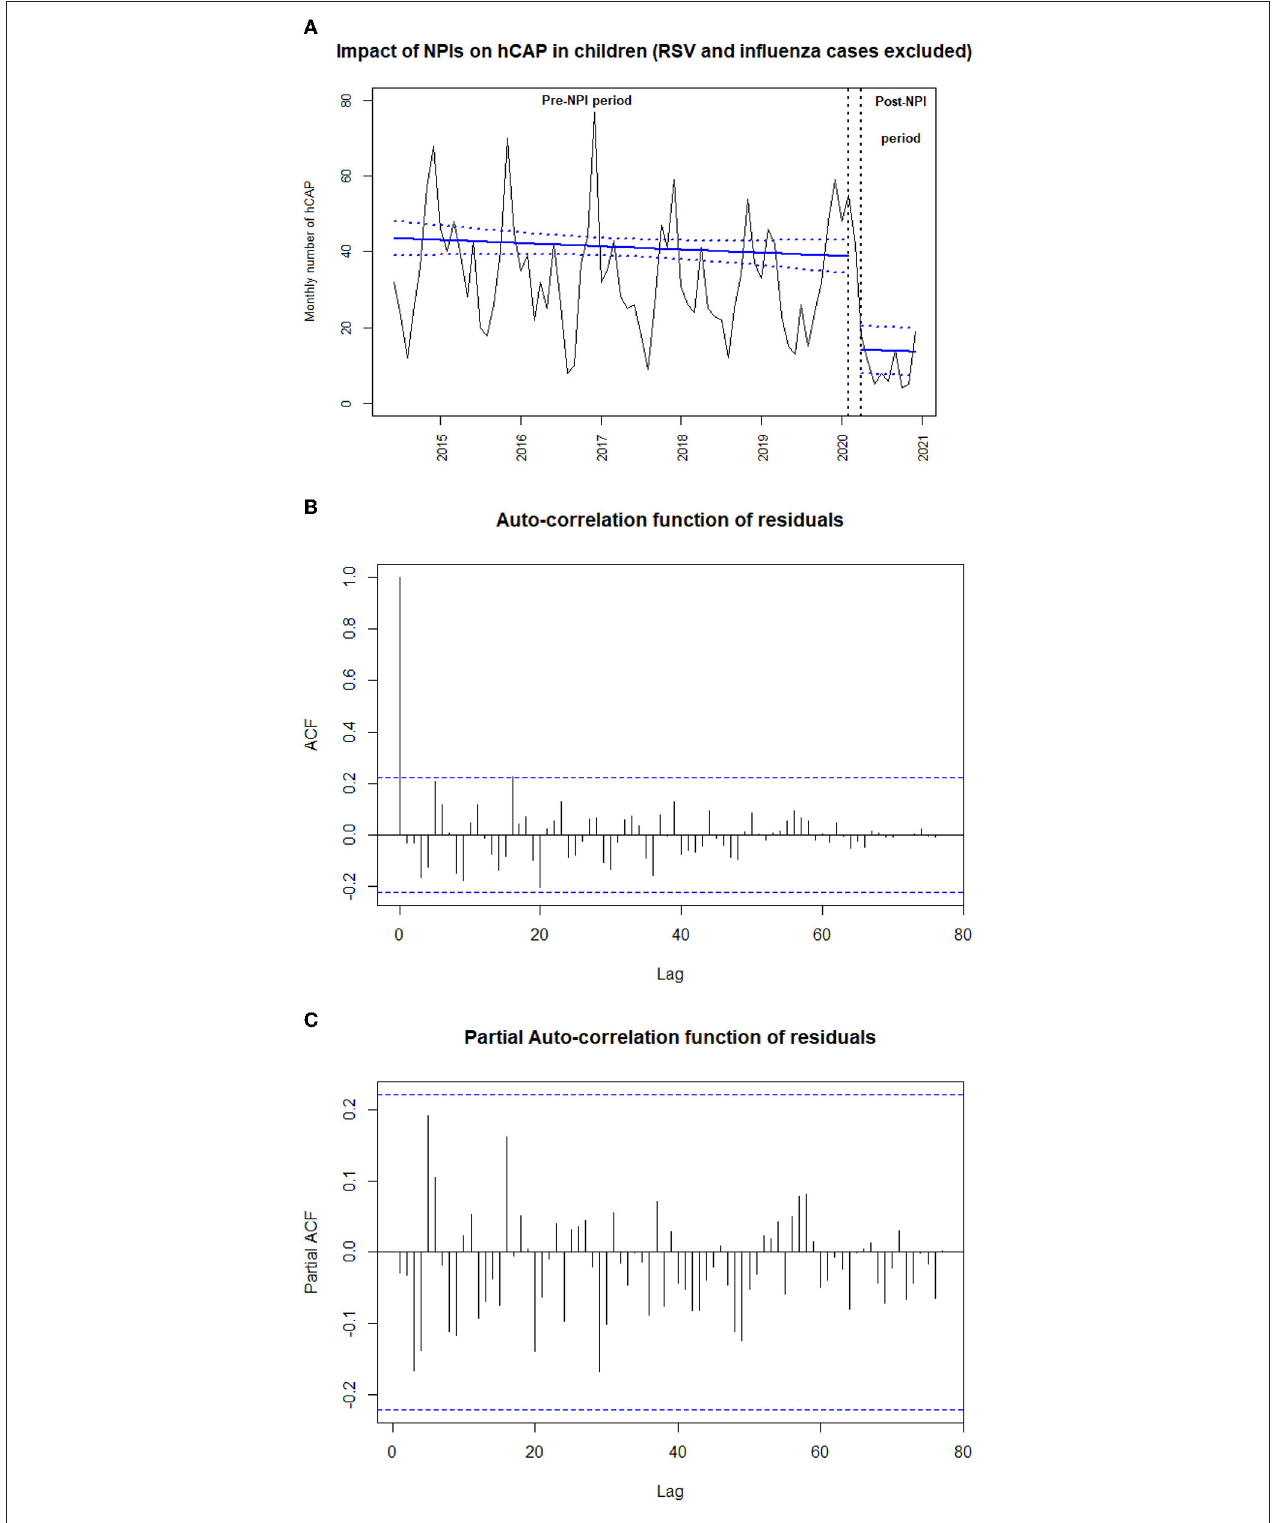
FIGURE 2 | (A) Impact of non-pharmaceutical interventions (NPIs) on monthly number of hospitalized community-acquired pneumonia (hCAP) in children after exclusion of respiratory syncytial virus and influenza virus cases from June 2014 to December 2020 ( N = 2,968). The black line shows the observed data. The bold blue slope shows the model estimates based on observed data (linear regression modeling) with confidence intervals represented as dashed lines. March 16, 2020